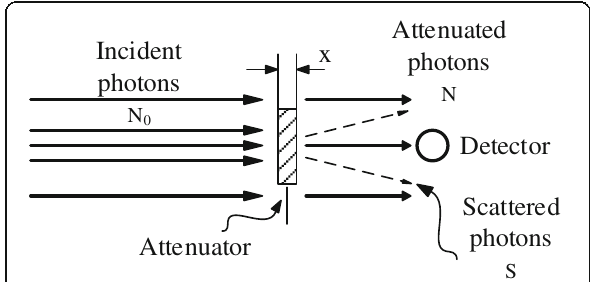
Fig. 2 Schematic diagram of photons interacting with a material (adapted from Cunningham